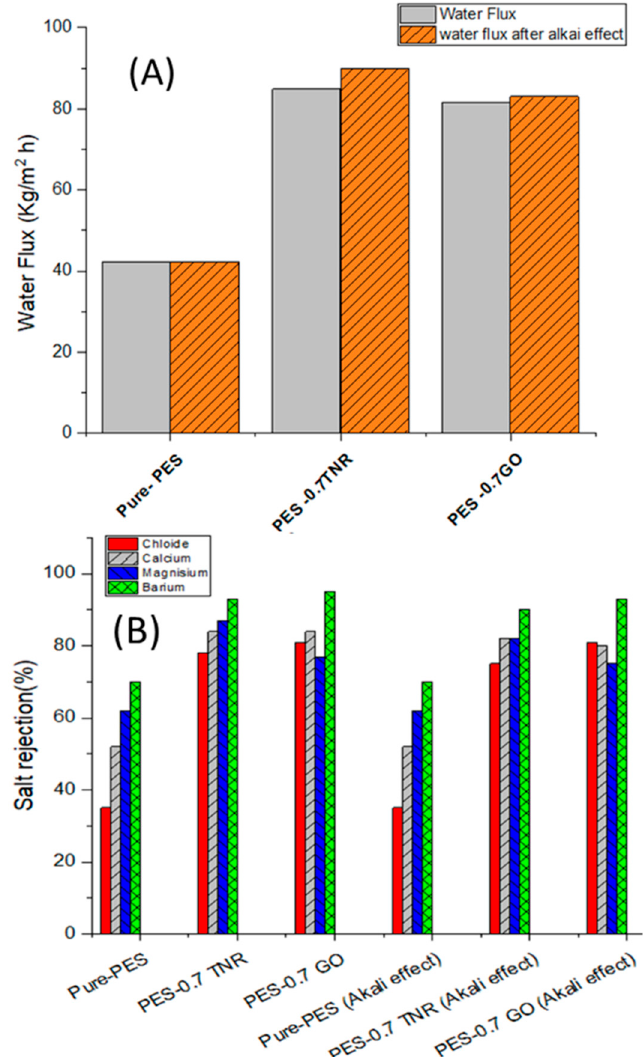
Figure 7. ( A ) Water flux and ( B ) salt rejection of synthesized pure-PES, PES-TNR, and PES-GO membranes before and after NaOH immersion for three days.